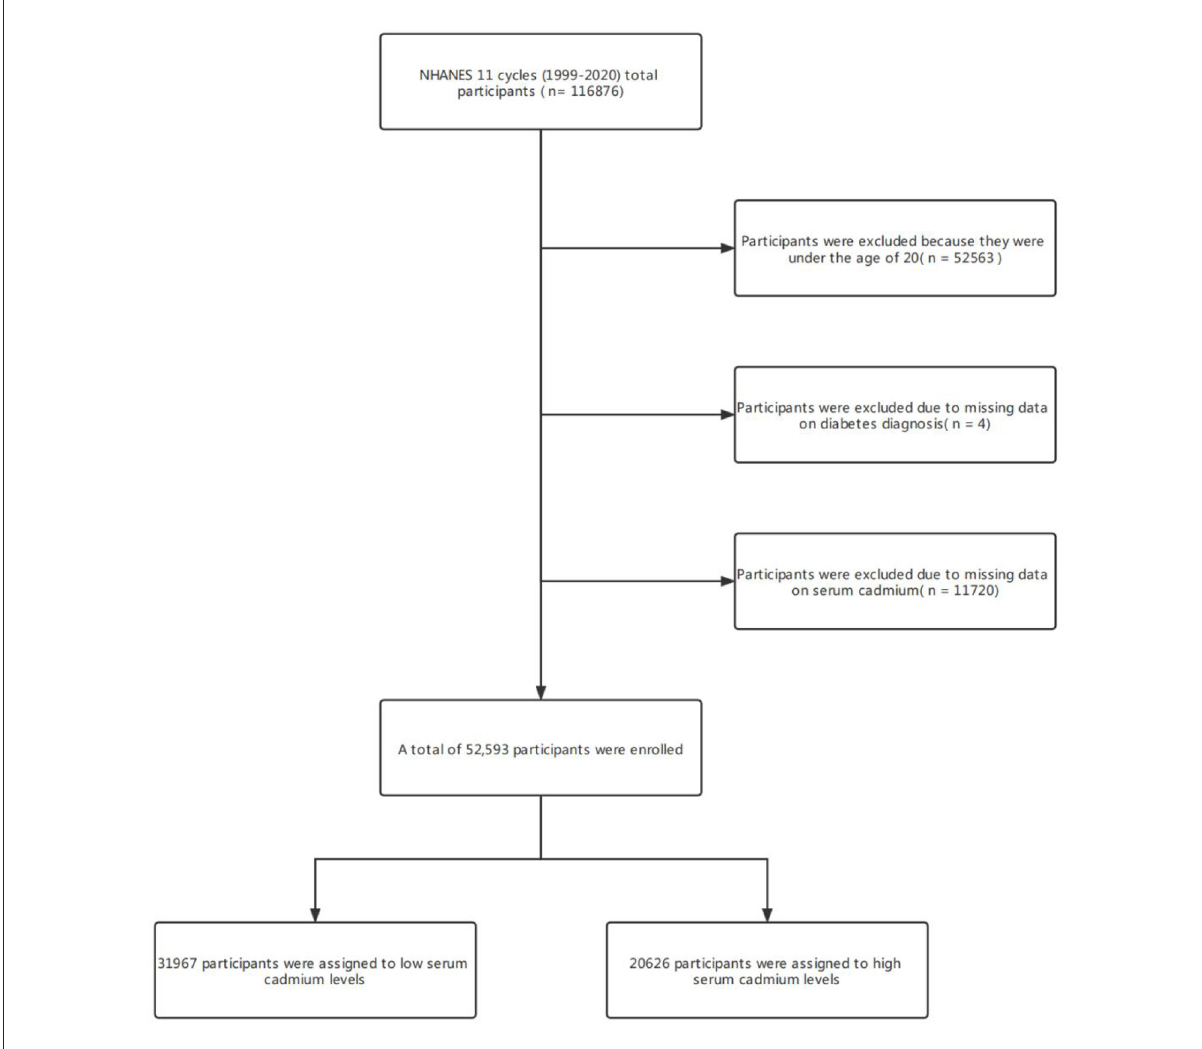
FIGURE1 Flowchart of participant